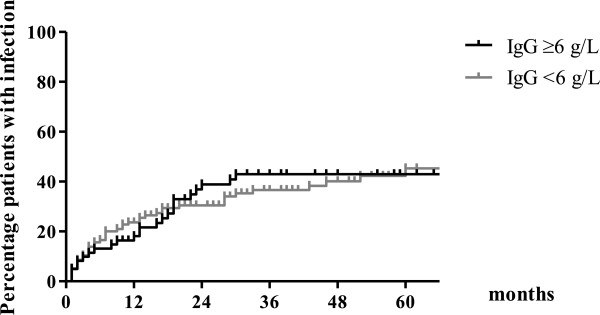
Time to first severe infection following first rituximab. Time to first severe infection according to IgG levels. The time to first severe infection was not different when patients with IgG levels ≥6 g/L (N = 116) and IgG levels <6 g/L (N = 61) (p = 0.953) were compared.